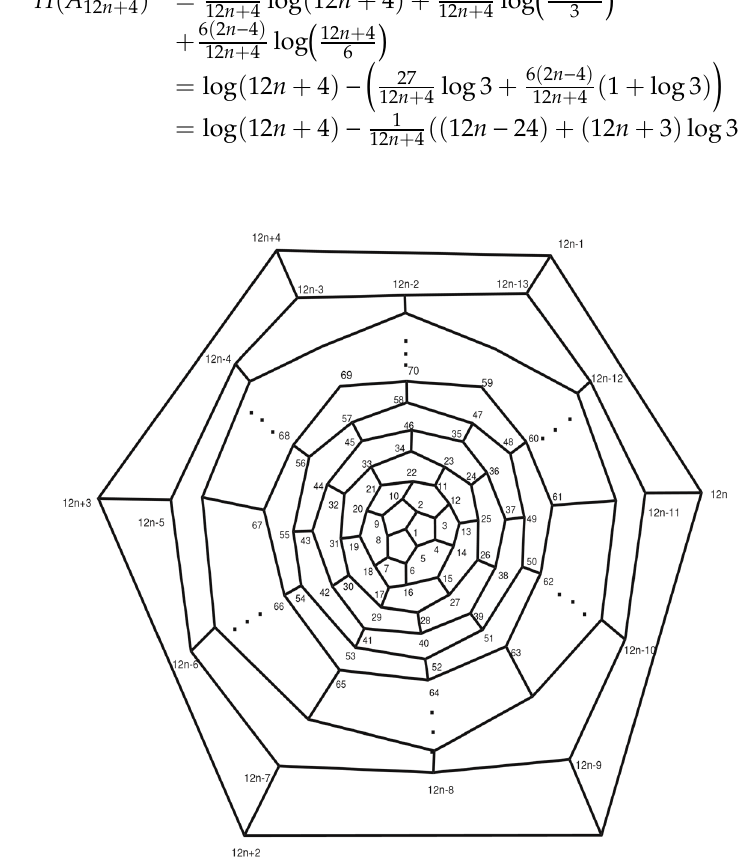
Figure 12. The fullerene A 12 n+ 4 .